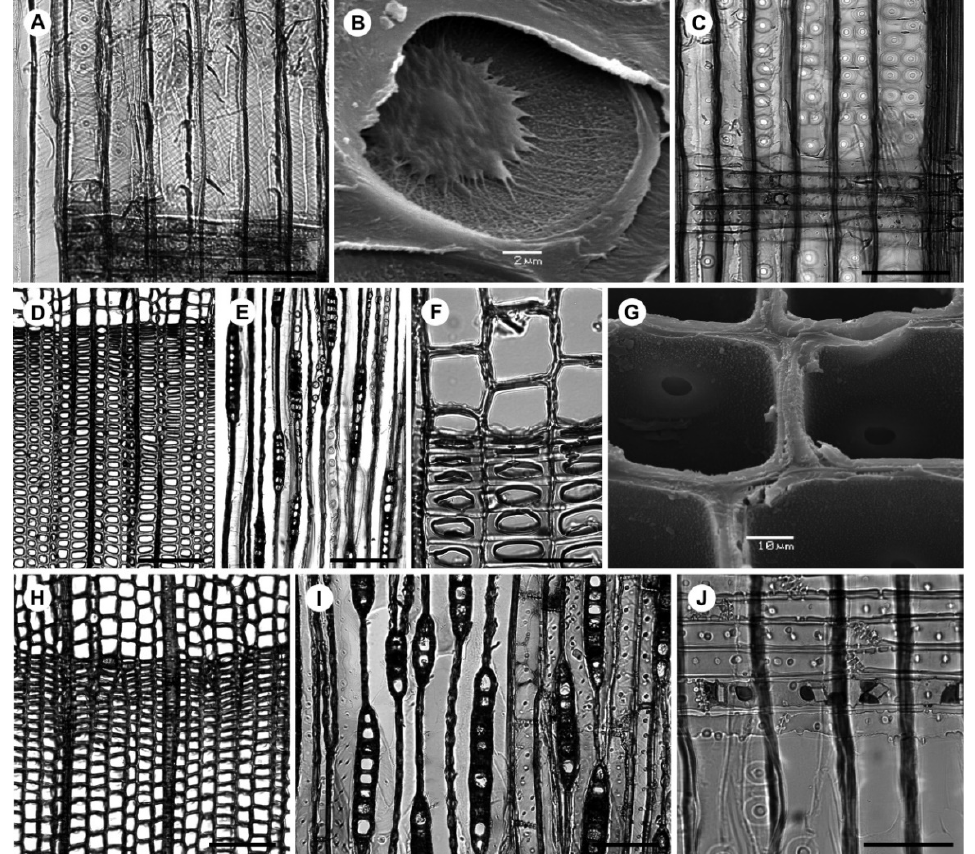
Figure 3. Axial tracheids, axial parenchyma and crystals. ( A – G ) Axial tracheids. ( A ) Helical thickenings Pseudotsuga sinensis . ( B ) SEM, scalloped tori Cedrus atlantica . ( C ) Biseriate tracheid pitting Larix occidentalis . ( D ) Organic deposits in tracheids Abies pinsapo . I Tracheid pitting in tangential walls Keteleeria evelyniana . ( F ) Tracheid pitting in tangential walls on the growth ring boundary Abies nordmanniana . ( G ) SEM, warty layer Abies pinsapo . ( H – I ) Axial parenchyma. ( H ) Marginal parenchyma Tsuga mertensiana . ( I ) Nodular transverse end wall Pseudolarix amabilis . ( J ) Crystals in ray parenchyma cells Abies procera . Scale bars: in ( B ) = 2 μ m, in ( G ) = 10 μ m, in ( F , J ) = 50 μ m, in ( A , C ) = 100 μ m, in ( D , E , H , I ) = 150 μ m.